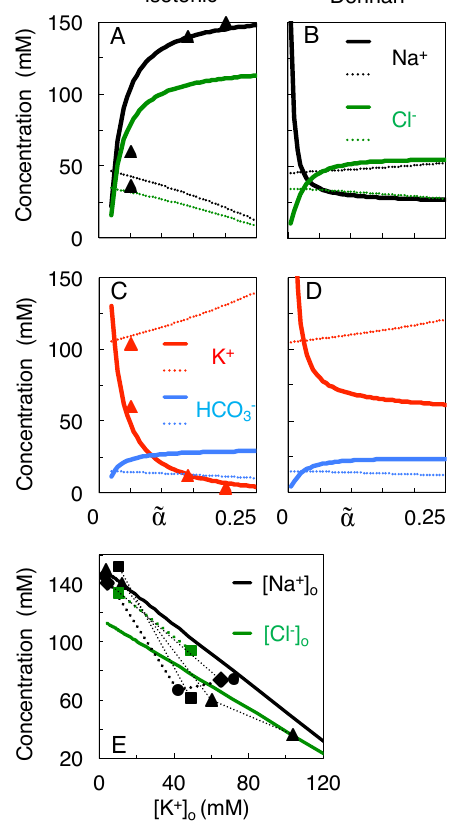
Figure 3. Concentration-volume curves for the permeant ions during isotonic mixing ( A , C ), as compared to mixing to the Donnan equilibrium at each intermediate volume ˜ α ( B , D ). Thick and thin curves plot extra- and intracellular concentrations, respectively. Data points (cid:52) in ( A , C ) are from Supplementary Table S2 of Reference [44]. ( E ) Theoretical prediction of the profile of [Na + ] o (black solid line) and [Cl − ] o (green) against [K + ] o . Data points are from Reference [44] ( (cid:52) ), [45] ( (cid:3) ), [46] ( ◦ ), and [9] ( ♦ ). Data from the same reference are connected by dotted lines, but may have been compiled from different